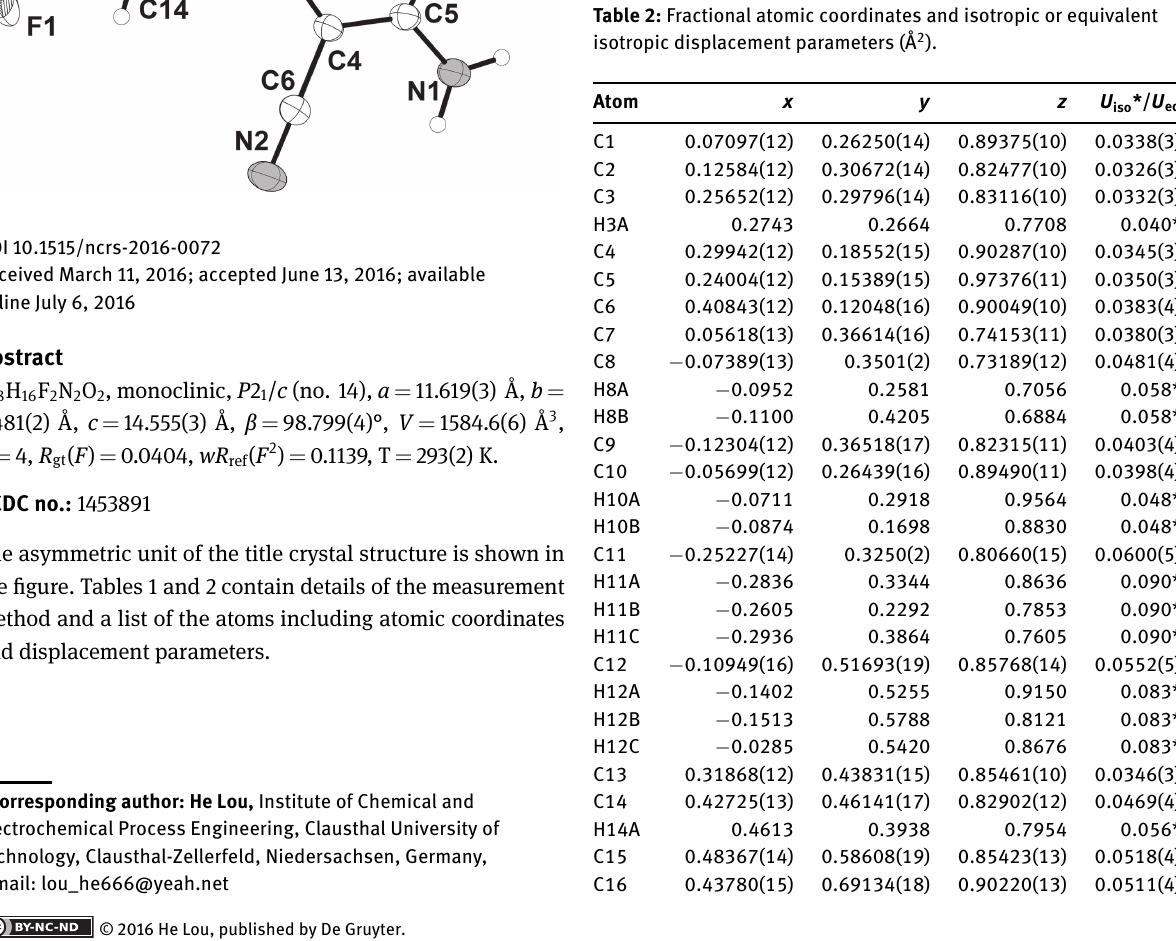
Table 2: Fractional atomic coordinates and isotropic or